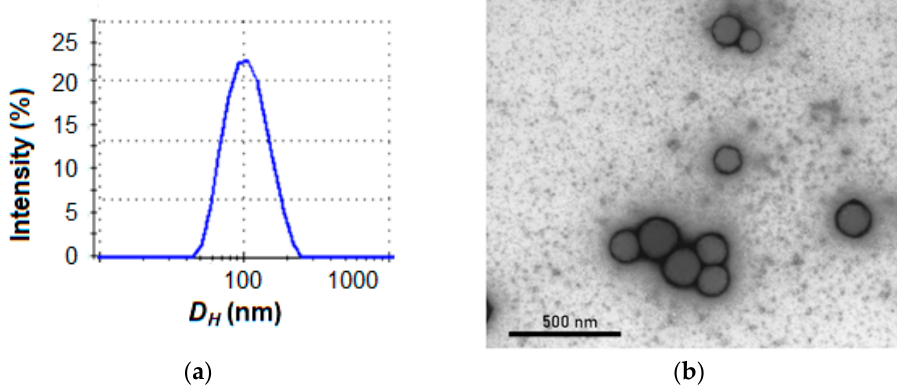
Figure 3. DLS analysis ( a ) and TEM microphotograph ( b ) of sample K(HC)F-2.